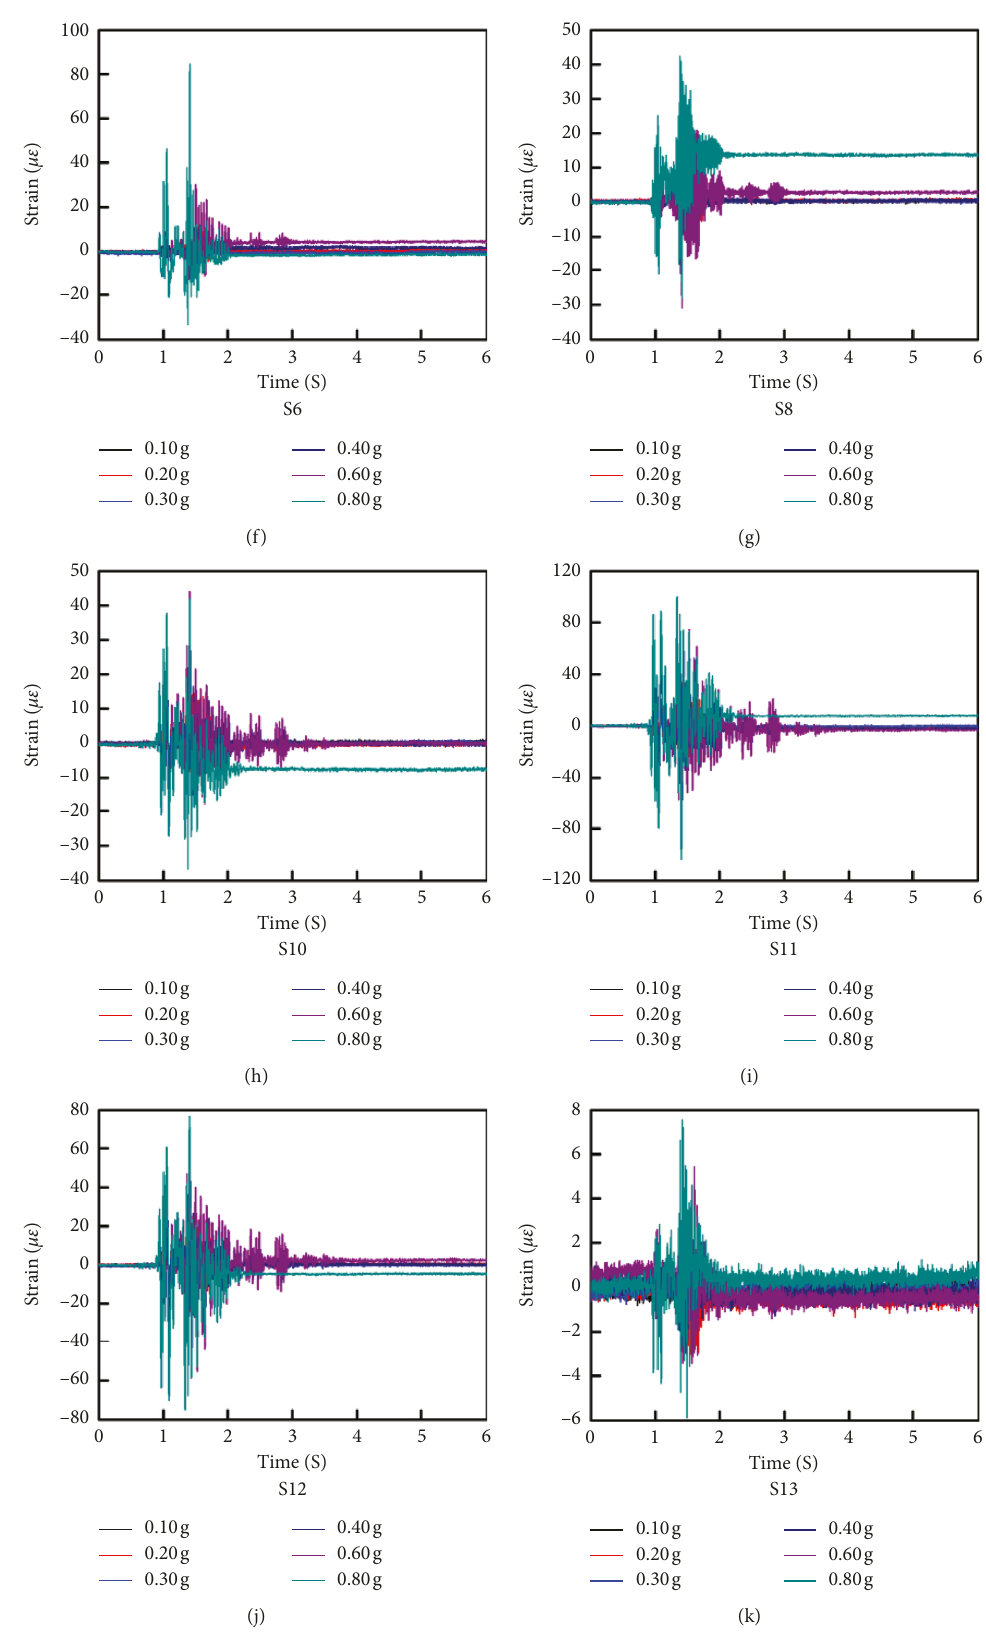
Figure 17: Time histories of the strain of the subway station structure under the Kobe ground